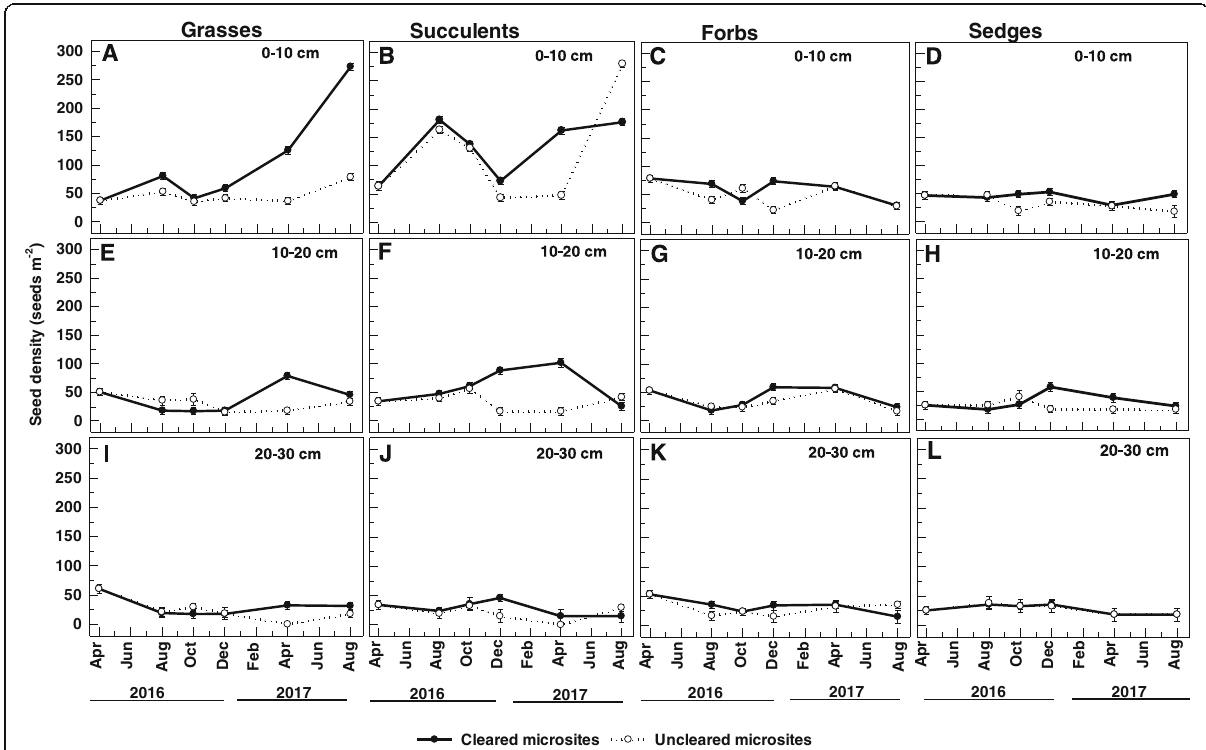
Fig. 3 Soil seed density of various plant functional groups at various burial depths in cleared and uncleared microsites at Kgomokgomo from April 2016 to August 2017. The presented data are back-transformed means and error bars represent ± standard error of